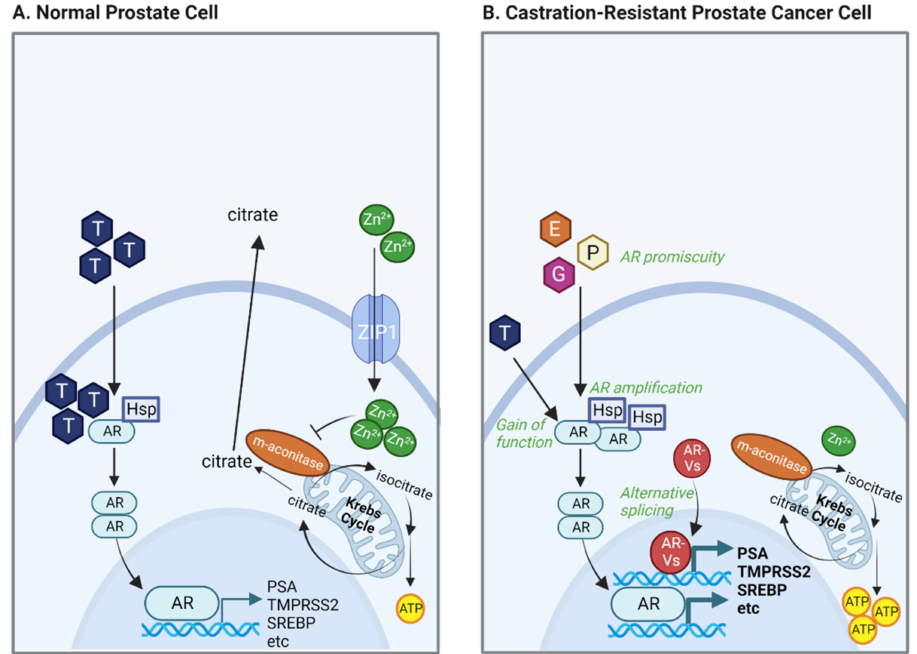
Figure 1. Metabolic reprogramming involved in PCa progression to CRPC. Alterations in Zinc-driven metabolism and AR pathway are observed as prostate cancer progresses to CRPC. Mechanisms of androgen resistance include AR promiscuity, amplification, gain of function and alternative splicing (Created with BioRender.com). T—testosterone; E—estrogen; P—progesterone;